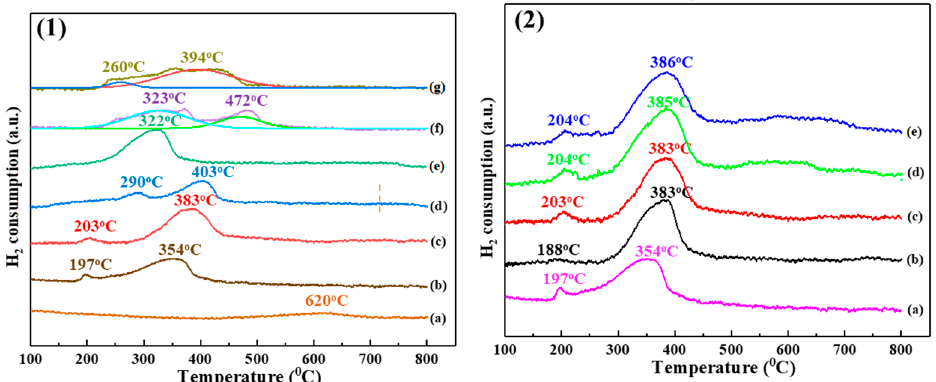
Figure 6. (1) H 2 -TPR profiles of M-Ce80Zr20 support and 15CuO-3MO x /M-Ce80Zr20 (MO x = La 2 O 3 , Fe 2 O 3 , PrO 2 , Sm 2 O 3 , MnO 2 ) catalysts: ( a ) M-Ce80Zr20, ( b ) 15CuO/M-Ce80Zr20, ( c ) 15CuO-3Fe 2 O 3